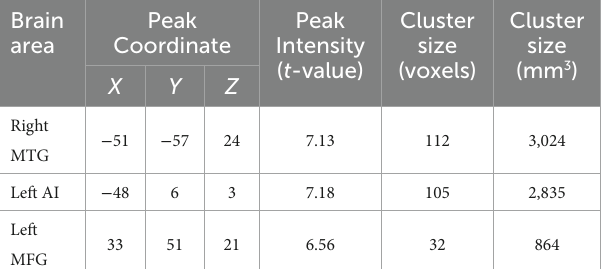
TABLE 3 Changes in functional connectivity based on medial prefrontal cortex (mPFC) in the salience network (SN), executive control network (ECN), and default mode network (DMN) in individuals with heroin use disorder (HUD) after 1 year follow-up. Brain area